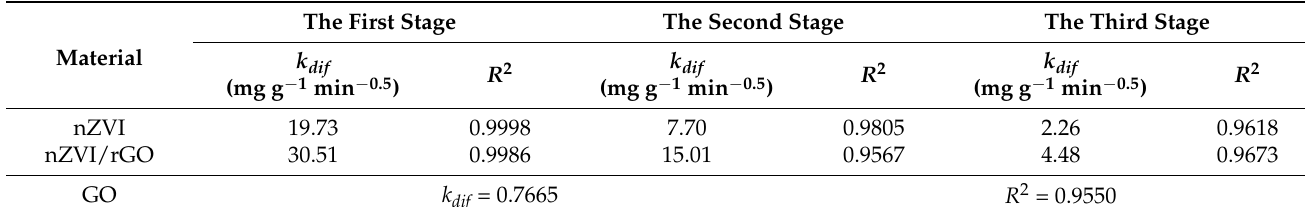
Table 3. Parameters of the intraparticle diffusion models for different materials.